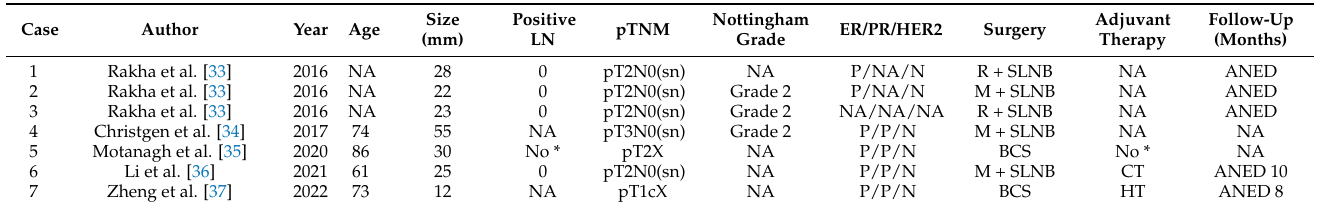
Table 2. Clinicopathological findings of invasive lobular carcinoma with papillary